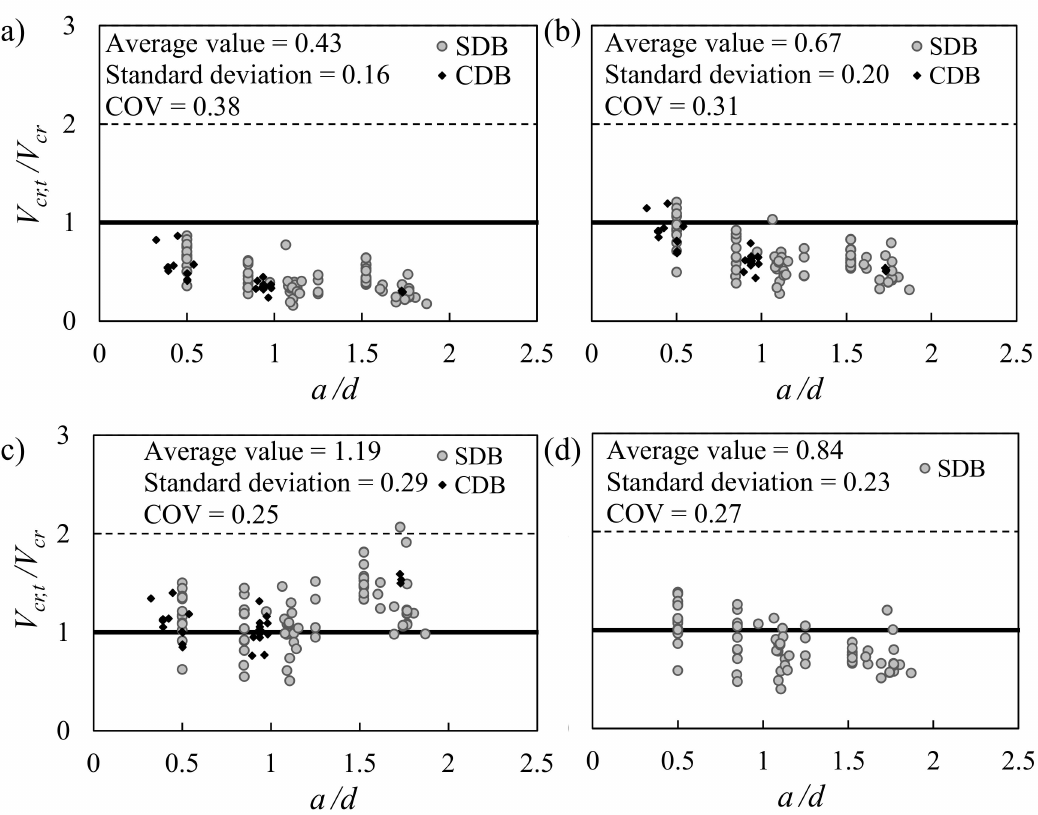
Figure 4. Comparison between test results and predictions of existing diagonal tension cracking models. ( a ) Foster’s model [19]; ( b ) Sahoo’s model [20]; ( c ) Birrcher’s model [18]; ( d ) Kim’s model